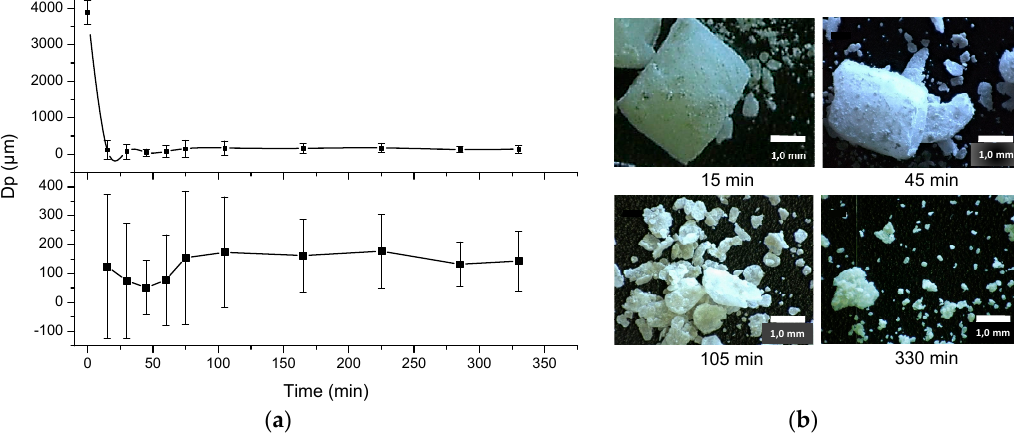
Figure 1. ( a ) Micrograph from spray-dried sPS using the two-fluid nozzle at optimal settings; ( b ) fractionated sPS powder after 15 min of ball milling. The powder marked in the red square was analyzed for PSD (see Section 3.3).